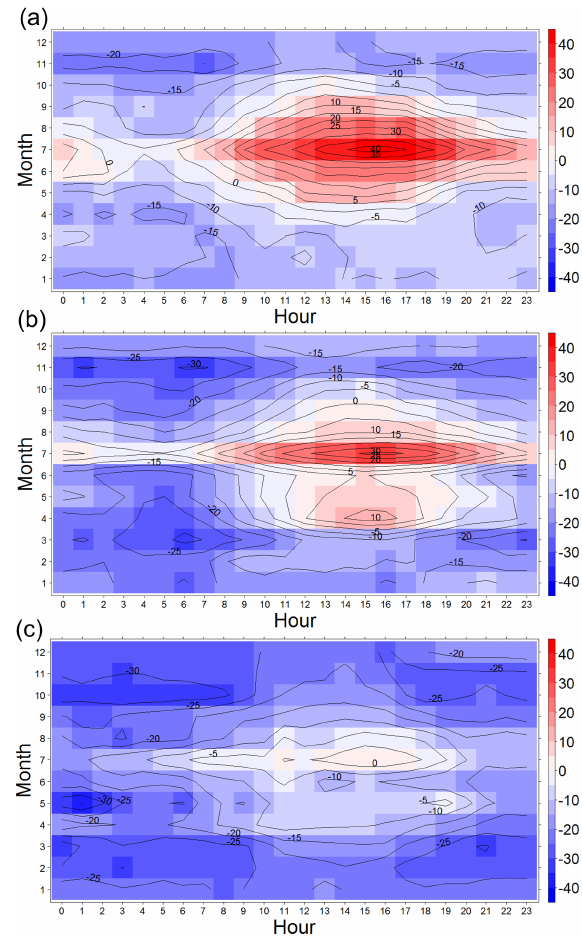
Figure 4. Monthly–hourly average differences between hemi- spheric background O 3 and regional background O 3 concentrations (µgm − 3 ) for (a) 2001 and (b) 2011 in south-east England, the area for which Harwell is representative, and (c) the difference between hemispheric and measured O 3 concentrations for 2012 at Auchen-